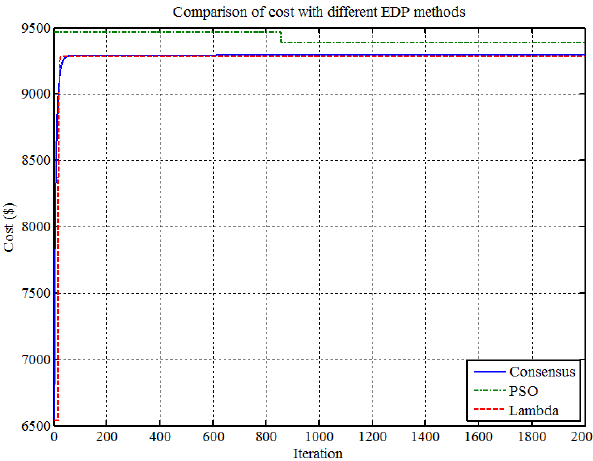
Figure 14. Cost comparison between lambda iteration, PSO and consensus